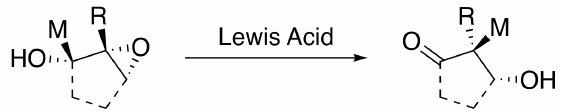
Figure 1. Lewis Acid-mediated Type III semipinacol rearrangement reaction converts 2,3-epoxyalcohols into the corresponding 1,3-ketol with concurrent 1,2-M group migration